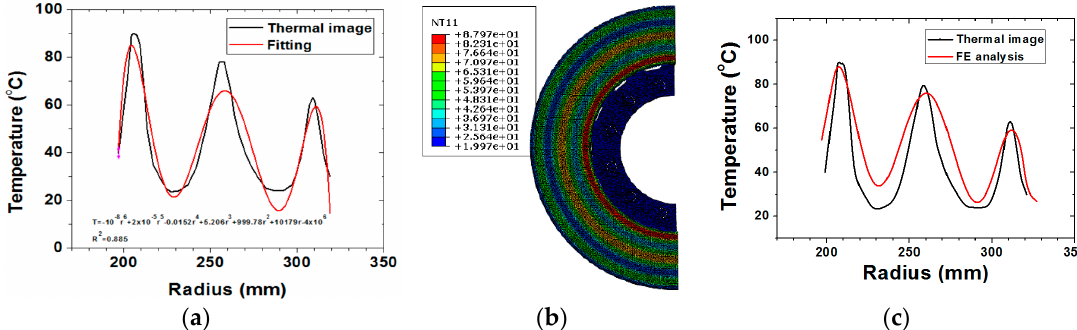
Figure 10. Comparison of thermal image temperature and finite element results. ( a ) Curve fitting of Figure 4a; ( b ) Finite element analysis; ( c ) Comparison of two results.